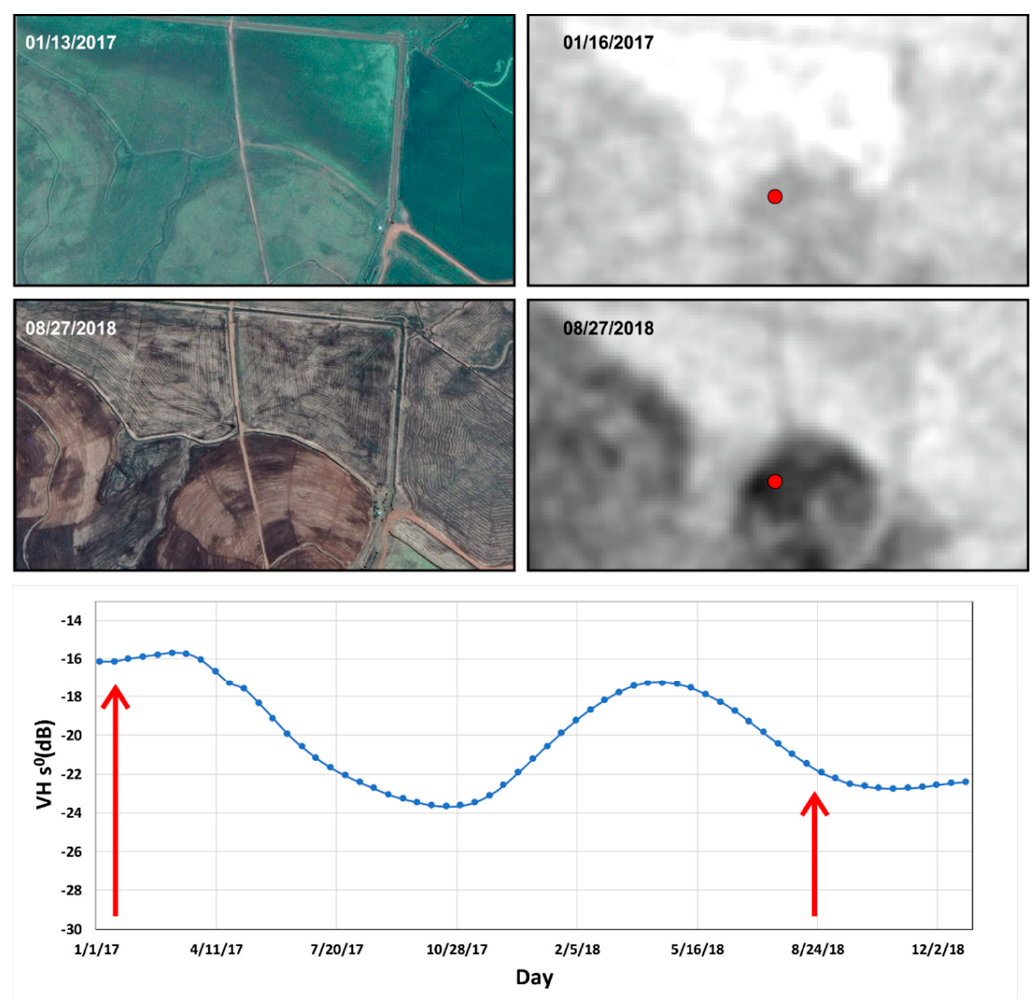
Figure 10. Google Earth and Sentinel 1 images for rice crop at two different times: planting under development (13 January 2017) and at the beginning of planting (27 August 2018). The time trajectory of the pixel marked in red in the Sentinel 1 images shows the positioning of the scenes over time (red arrows).